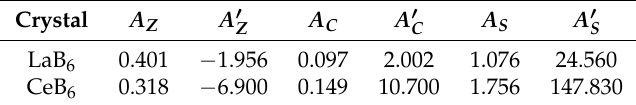
Table 7. Anisotropic factors A of LaB 6 and CeB 6 and their pressure derivatives A (cid:48) ( × 10 − 4 ). Crystal A